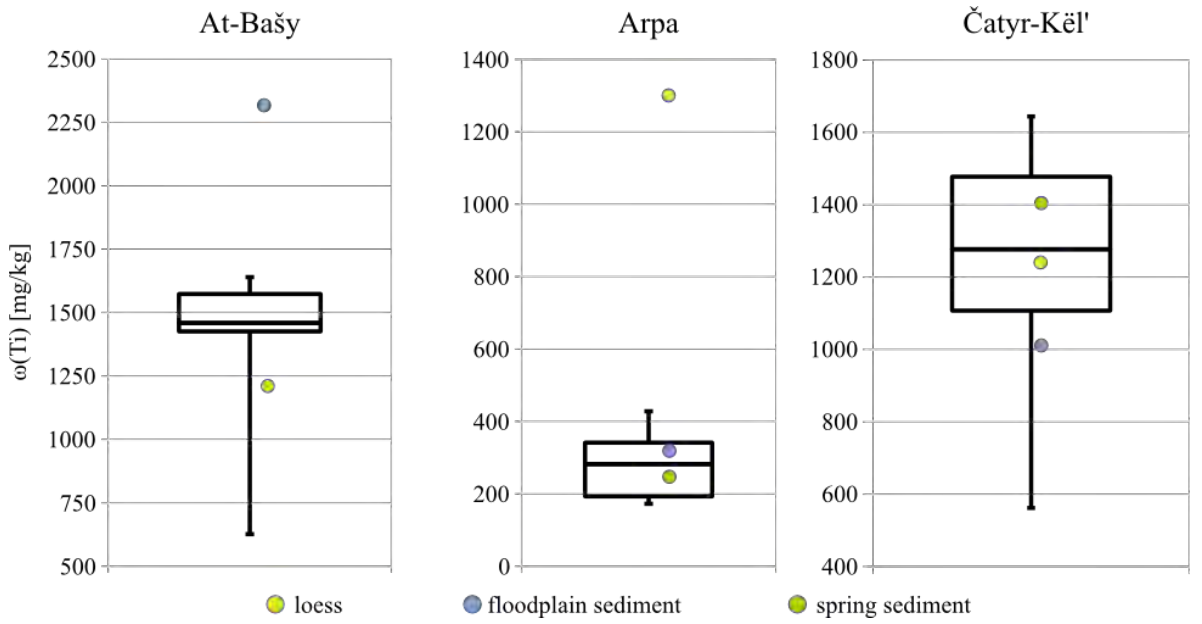
Figure 8. Mass fraction of titanium of the peatland substrate samples and the comparison samples. The box plots represent the values of the peatland substrate samples of the peatlands. The upper and the lower whiskers represent, respectively, the highest and lowest measured values. The circles represent the values for the comparison samples. To provide an overview, samples from all peatlands are depicted.